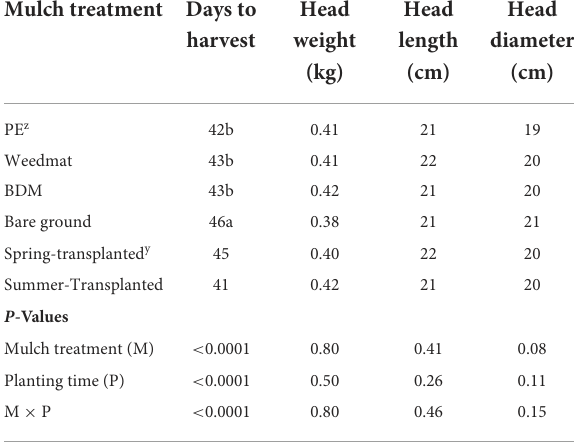
TABLE 8 Mean head weight (kg), length (cm), and diameter (cm) of lettuce cv. Green Star grown on a raised bed with polyethylene (PE), weedmat, soil-biodegradable plastic mulch (BDM), or bare ground treatments in two lettuce planting time (spring and summer) of rotation 1 following strawberry in a Mediterranean climate,